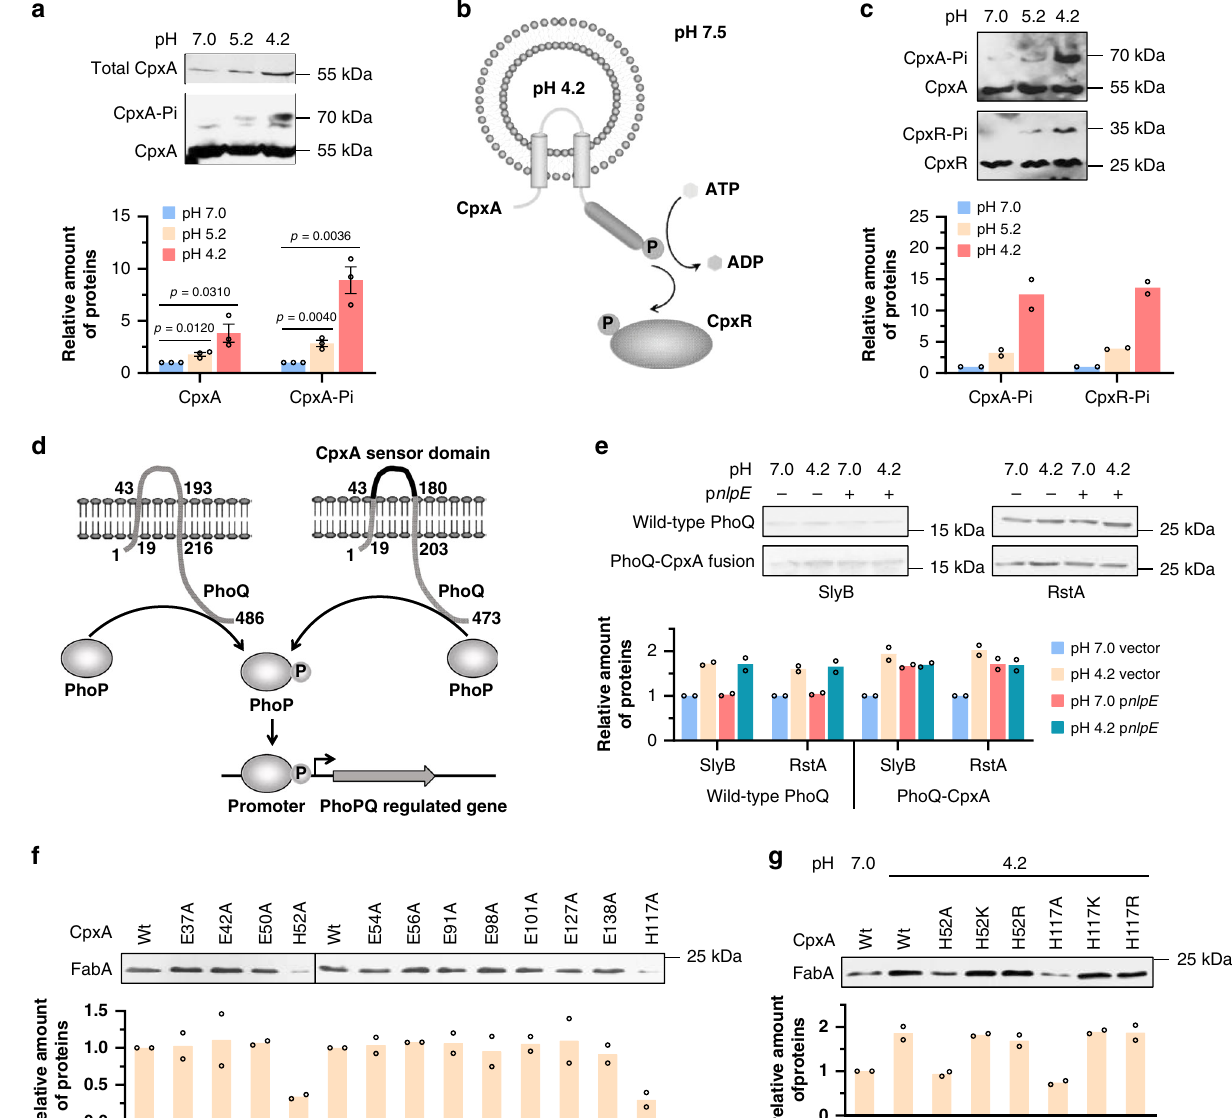
Fig. 4 The CpxRA system is activated by protonation of CpxA periplasmic histidine residues. a Western blot of CpxA-His 6 protein in BW25113 strain after acidic challenge. For total CpxA protein, the same amount of total cellular proteins extracted from cells grown at different pH was applied to SDS- PAGE. For analysis of phosphorylated CpxA protein, the same amount of CpxA-His 6 protein puri fi ed from cells grown at different pH was separated using SDS-PAGE containing Mn 2 + and Phos-tag acrylamide, which retard the mobility of phosphoproteins. n = 3 biologically independent samples. b Schematic diagram of the proteoliposome system. c In vitro analysis of CpxA and CpxR phosphorylation induced by acidic pH, carried out using reconstituted proteoliposomes, which were preloaded with buffers at different pH and puri fi ed CpxA-His 6 protein. To analyze phosphotransfer, puri fi ed His 6 -CpxR was incubated with CpxA-His 6 -containing proteoliposome in phosphorylation buffer. n = 2 biologically independent samples. d Design and construction of a PhoQ-CpxA fusion protein. PhoPQ is a known two-component system which can sense the acidic pH, and activate transcription of rstA and slyB genes. We replaced the sensor domain of PhoQ (amino acids 43 – 193) with the periplasmic domain of CpxA (amino acids 28 – 164). e Western blot of RstA and SlyB proteins in BW25113 with wild-type PhoQ or PhoQ-CpxA fusion at pH 7.0, at pH 4.2, with NlpE overexpression, and at pH 4.2 with NlpE overexpression. n = 2 biologically independent samples. f Western blot of FabA-His 6 protein in BW25113 strains carrying wild-type CpxA or CpxA mutants in which the periplasmic histidine/glutamate was replaced with alanine at pH 4.2. n = 2 biologically independent samples. g Western blot of FabA-His 6 protein in BW25113 strains carrying wild-type CpxA or CpxA mutants in which the histidine at positions 52 and 117 was replaced by alanine, lysine, and arginine, respectively. n = 2 biologically independent samples. Error bars, mean ± SEM. Two-tailed Student ’ s t tests were performed to determine the statistical signi fi cance for two group comparisons. The source data are provided as a Source Data fi